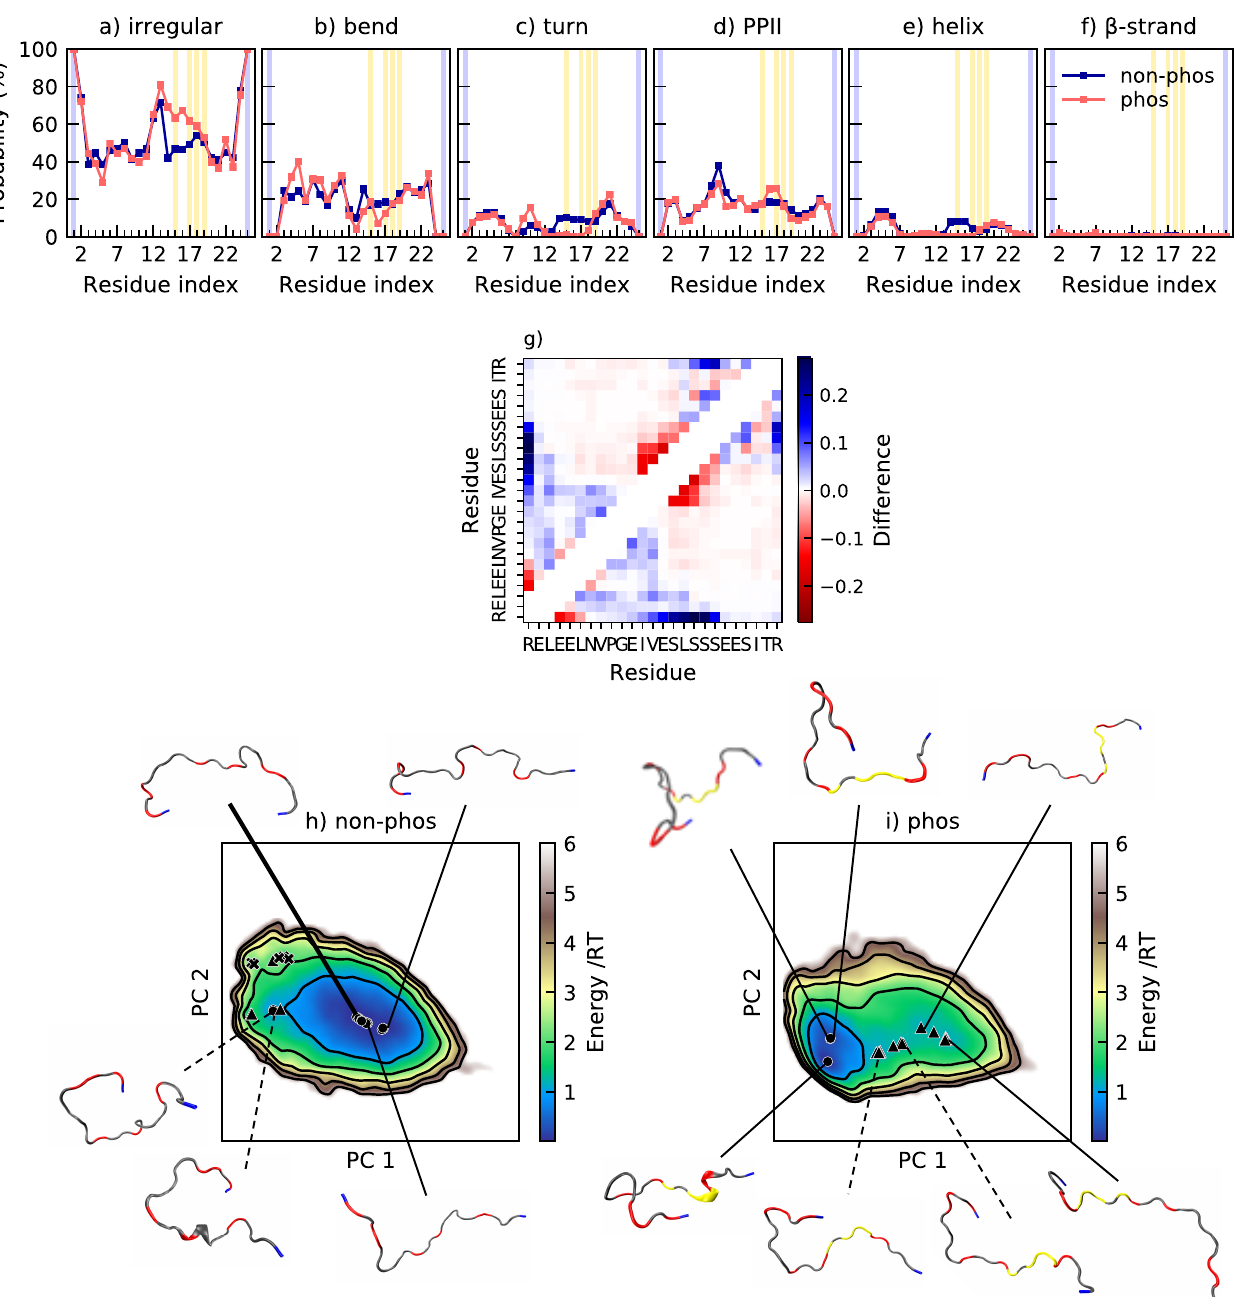
Figure 6. ( a – f ) Secondary structure content along the non-phosphorylated and phosphorylated sequence of bCPP. Helix includes α -helix and 3 10 -helix. β -strand includes also β -bridge. The data for the phosphorylated peptide are previously published in [31]. The positions of phosphorylated and positively charged residues are highlighted in yellow and blue, respectively; ( g ) change in contact probability upon phosphorylation of bCPP; ( h , i ) energy landscapes and conformations in minima of non-phosphorylated and phosphorylated bCPP. The energy landscapes are constructed using the first two components from principal component analysis, using the same basis set for both variants. Hence, they are directly comparable. Contour lines are drawn for integer energy levels in the interval 1 ≤ RT ≤ 5 and the minimum of each basin is represented by a marker depending on the energy: (cid:108) : ≤ 1 RT , (cid:115) : ≤ 2 RT , (cid:54) : ≤ 3 RT . A thick line corresponds to the most populated basin, while dashed lines to the least populated basins. In the conformations, positively charged residues are shown in blue, negatively charged residues in red and phosphorylated residues in